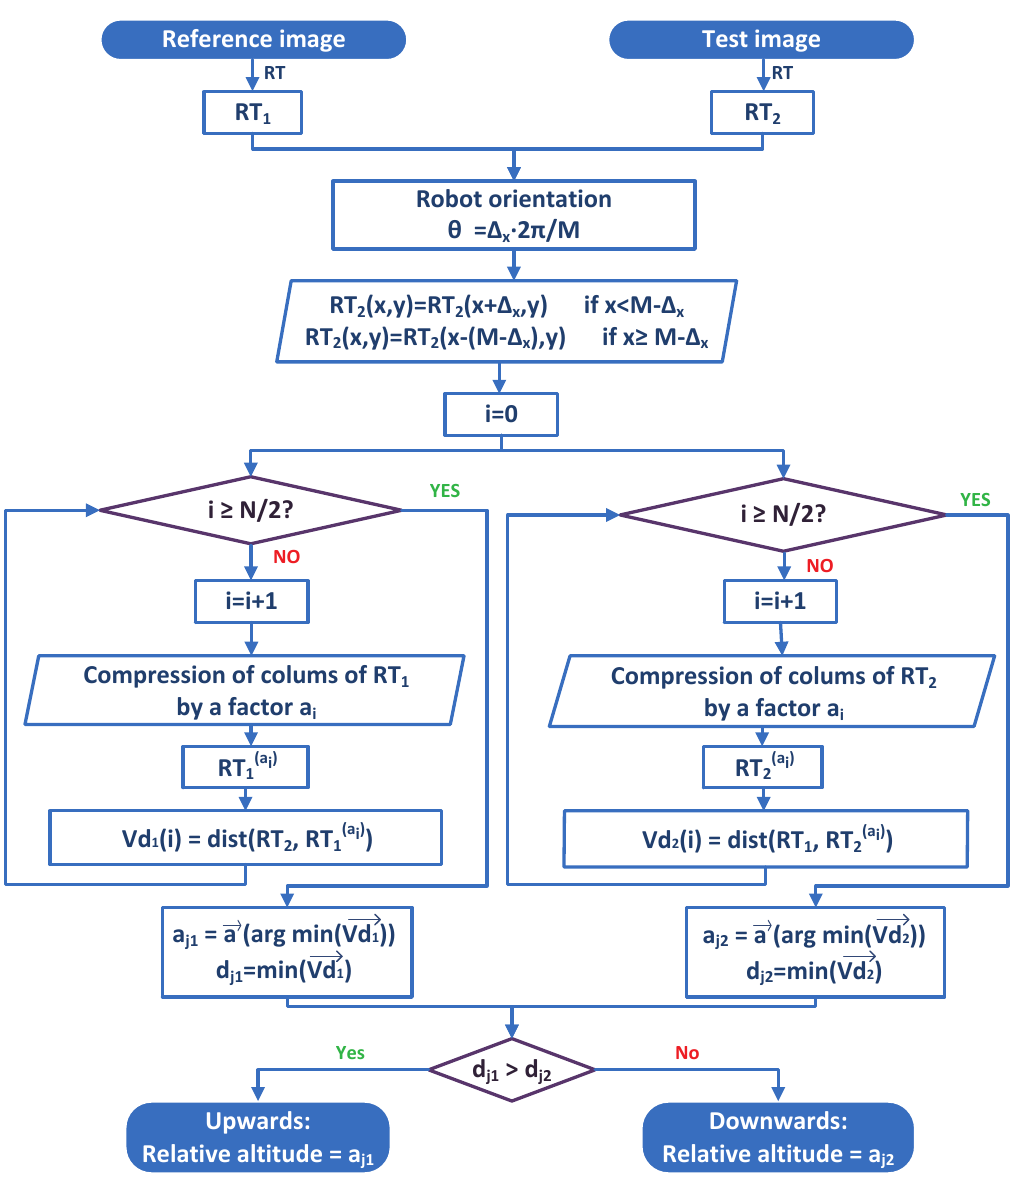
Figure 5. Flowchart of the altitude estimation